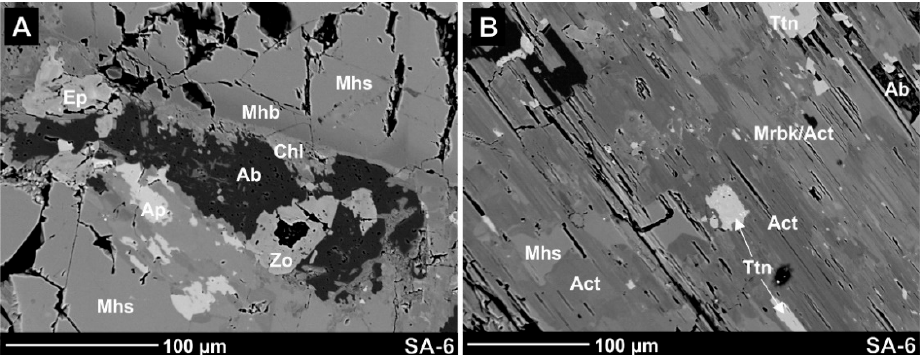
Figure 19. Metagabbro in the Silica Nappe Permian salinar mélange at Gemerská Hôrka (s. SA-6). ( A , B ) relics of the magmatic Mhs to Mhb and Pl. Newly formed Mrbk, Act and Chl partly replace magmatic amphiboles and coexist with other LT metamorphic phases such as Act, Ab, Ep, Zo and Ttn.